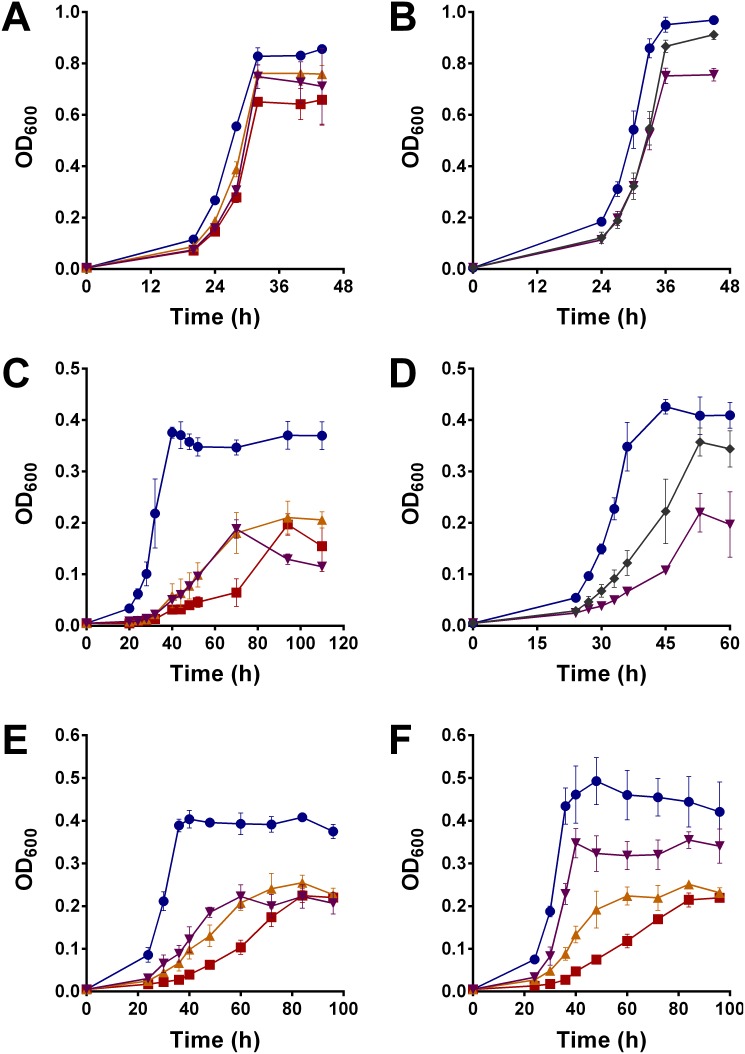
Observation, complementation, and recovery of mutant growth phenotypes.Strains were grown on HdB minimal medium. (A) Growth on 5.5 mM glycerol. (B) Complementation on 5.5 mM glycerol in the presence of 50 µg mL−1 hygromycin. (C) Growth on 12.5 mM acetate. (D) Partial complementation on 12.5 mM acetate in the presence of 50 µg mL−1 hygromycin. (E) Growth on 12.5 mM acetate in serum vials injected with 10% pure N2. (F) Growth on 12.5 mM acetate in serum vials injected with 10% pure H2. Legend: Blue circles = Wild-type (or wild-type with empty pOLYG vector for complementation); Red squares = Δhyd123; Orange point-up triangles = Δhyd1; Purple point-down triangles = Δhyd2 (or Δhyd2 with empty pOLYG vector for complementation); and Grey diamonds = Δhyd2 with pOLYG vector expressing MSMEG_2720-2719. Error bars show standard deviations from biological triplicates.